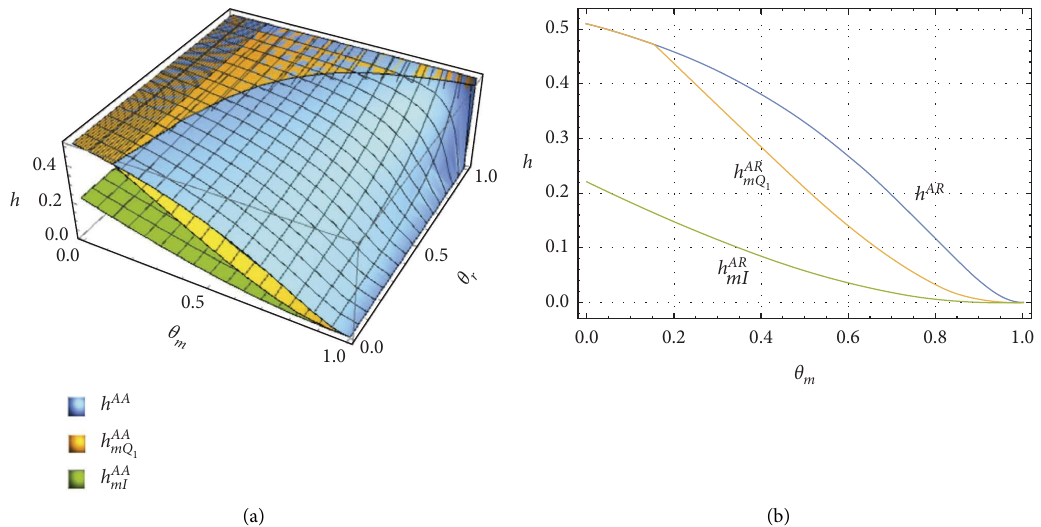
Figure 10: Tresholds of manufacturer altruism’s infuence on frst-period order quantities and inventories ( a � 1 , b � 0 . 5 ,c � 0 . 2 , c � 1 ) . (a) In scenario AAI. (b) In scenario ARI.